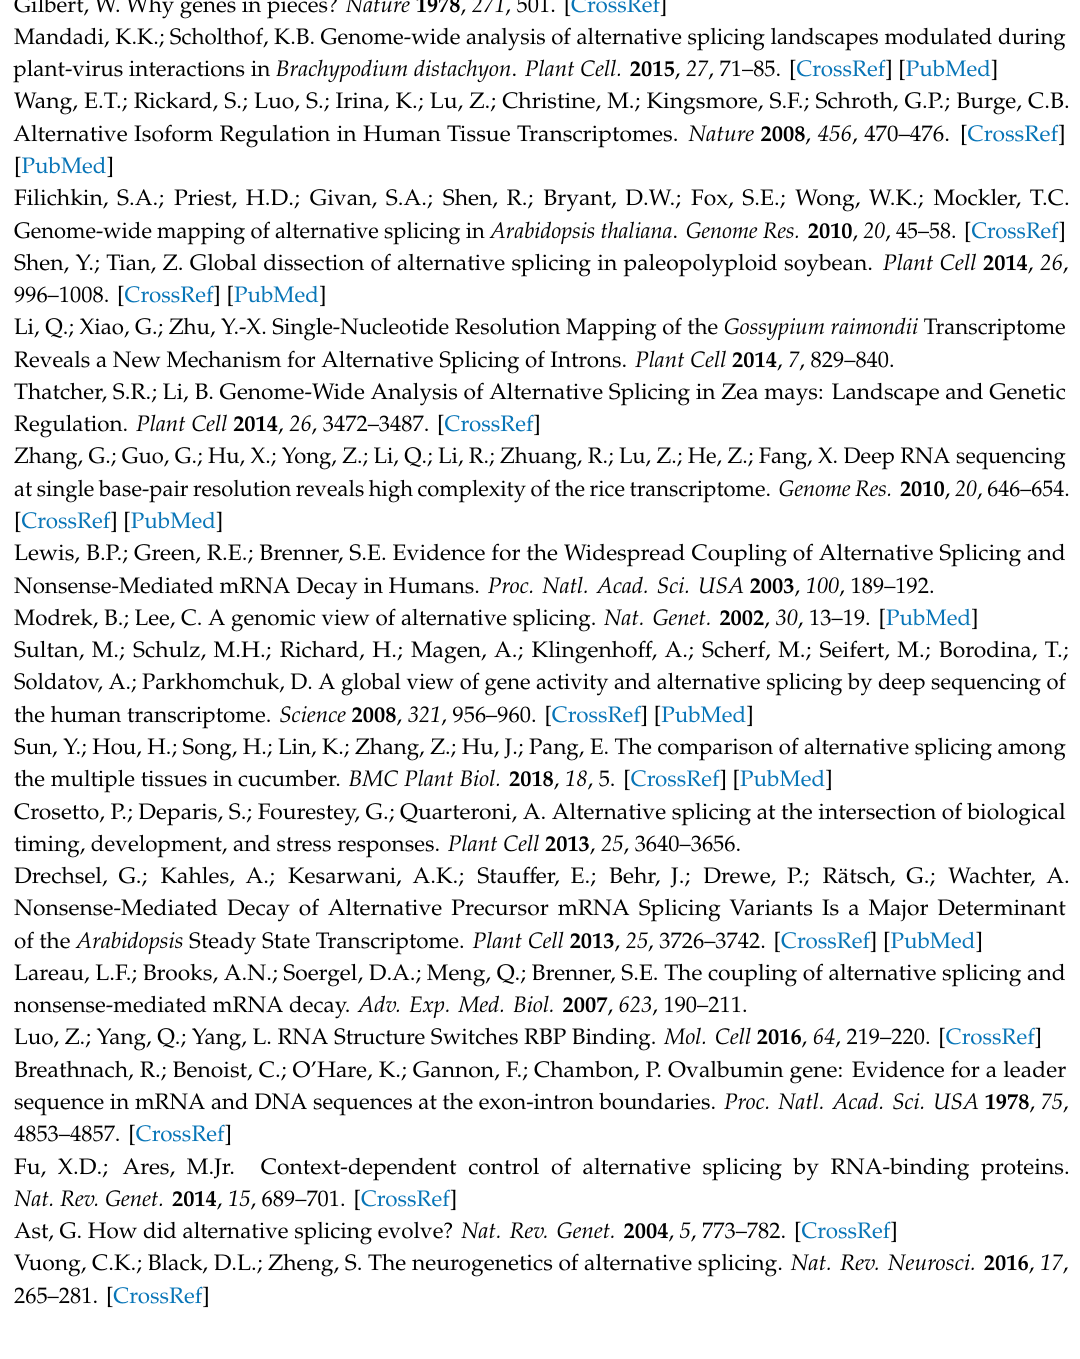
GO biological process categories of the eight modules. Figure S2: Enriched KEGG pathways categories of the eight